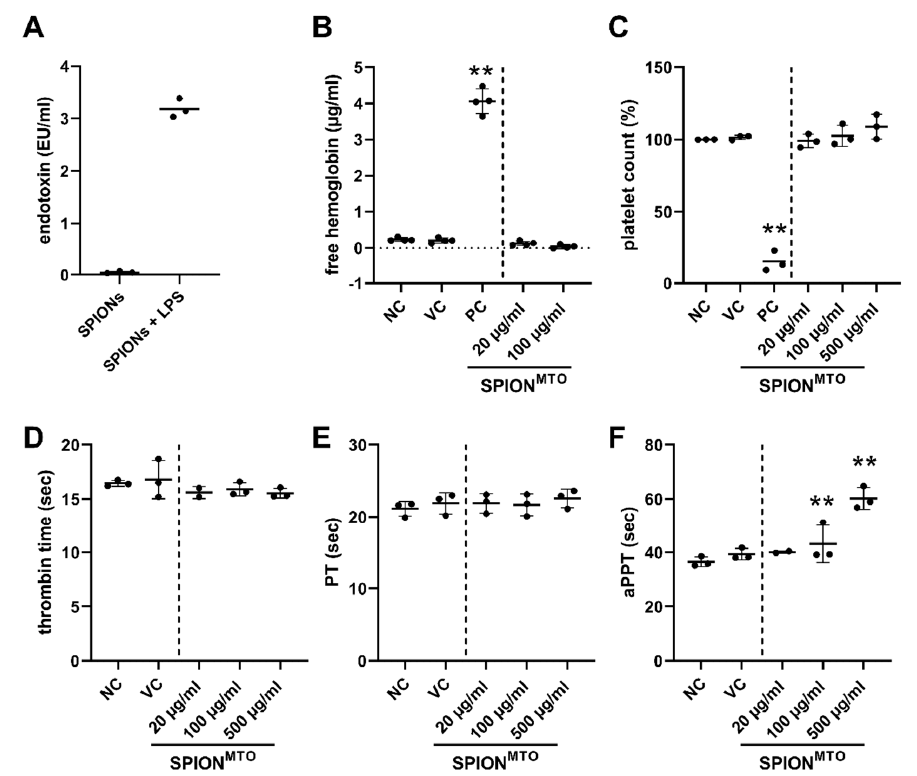
Figure 1. Blood compatibility of SPIONs. ( A ) Endotoxin content. Three batches of SPIONs were analyzed for endotoxin contaminations. Shown are the mean values with standard deviations of the three batches tested in duplicates of 25 µ g / mL iron content. For exclusion of assay interference, SPIONs were spiked with 5.0 EU / mL lipopolysaccharide (LPS) and spiking recovery was determined. ( B ) Hemolysis . Anticoagulated blood was incubated with SPIONs for 30 min. Then, the samples were centrifuged to remove erythrocytes and nanoparticles. Free hemoglobin in the supernatant was detected at 590 nm, reflecting hemolysis. Samples treated with Triton X-100 served as positive control (PC). ( C ) Platelet aggregation . Platelet-rich plasma was incubated with SPIONs for 15 min under continuous shaking. The number of platelets was measured by flow cytometry. Collagen-treated samples served as positive control (PC). ( D – F ) Plasma coagulation time. Human anticoagulated platelet-poor plasma was incubated with SPIONs for 30 min and then analyzed for coagulation. ( D ) thrombin time (TT), ( E ) prothrombin time (PT), ( F ) activated partial thromboplastin time (aPPT). Indicated concentrations refer to the iron content in the samples. (B-F) Experiments were performed in triplicates of blood from 3 healthy donors, every dot represents the mean values of one donor. The line indicates the mean values of all donors with standard deviations (**p ≤ 0.01; treated samples versus negative control, NC). In all samples, PBS served as negative control (NC), water as vehicle control (VC), the positive controls (PC) were selected individually for each readout.